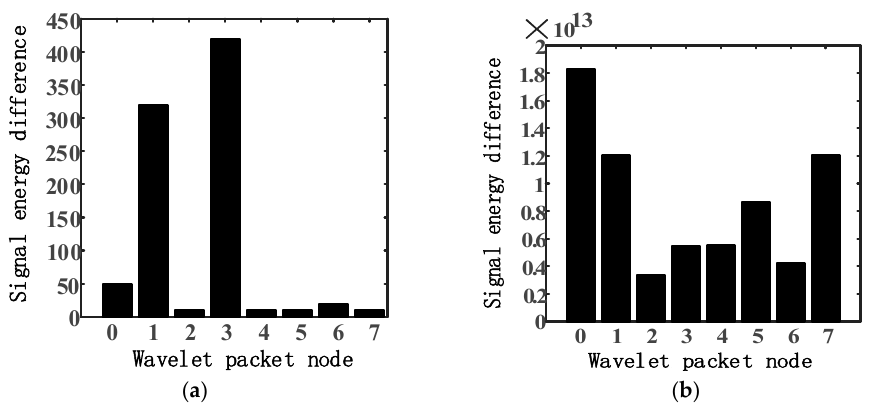
Figure 6. Wavelet packet node energy difference diagrams of the normal motor and the air gap eccentric fault motor. ( a ) Current signal; ( b ) radial electromagnetic force signal.